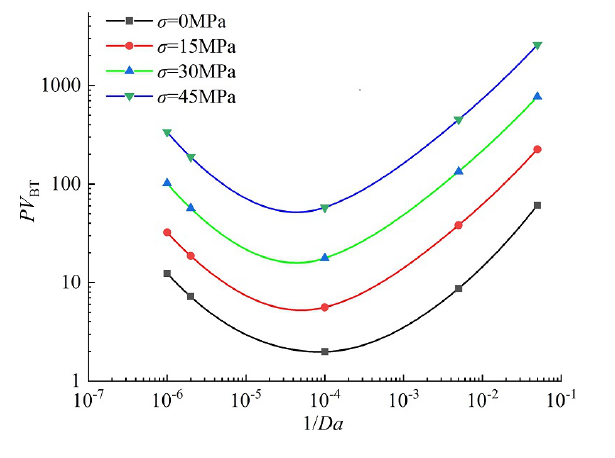
Figure 12. Comparison of the PV BT calculated under different effective stress